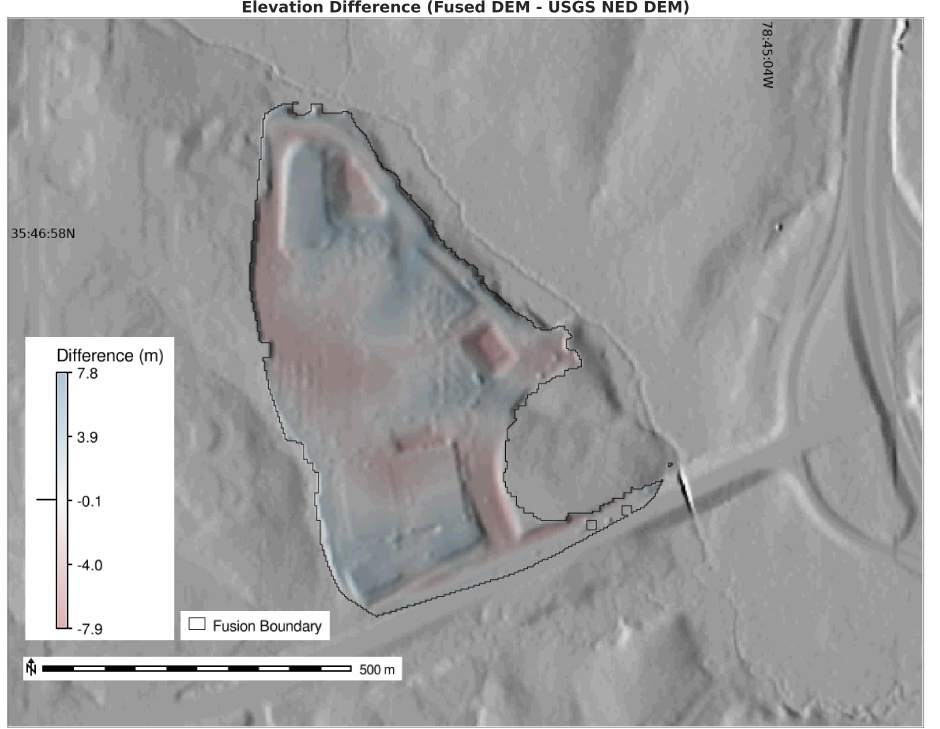
Figure 12. The difference in elevation of the fused DEM and the USGS NED DEM revealed how construction has modified Site 1’s topography.